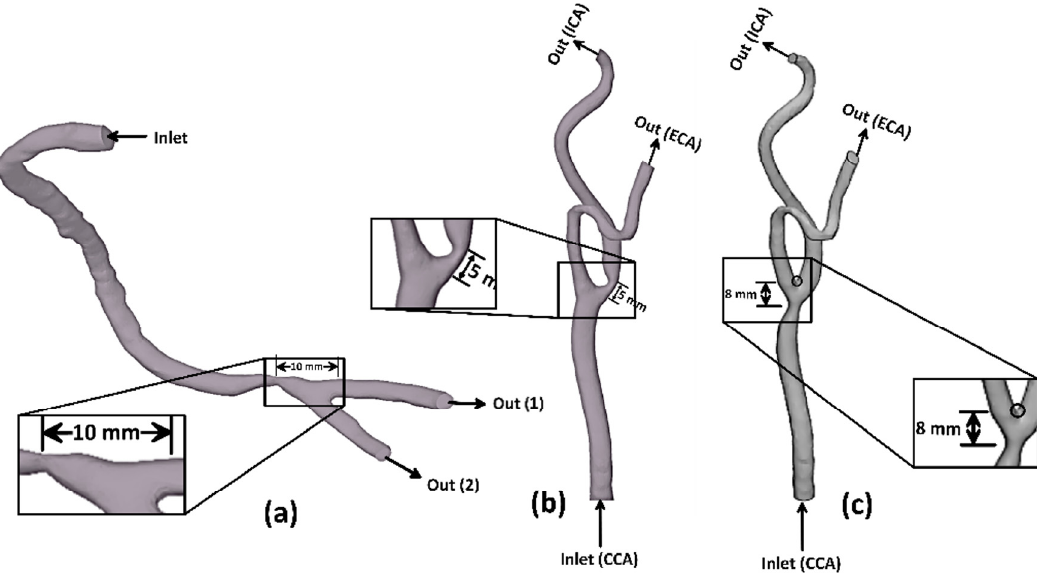
Figure 1. Physical model schematic diagram: ( a ) stenotic RCA—model A, ( b ) stenotic ICA—model B, and ( c ) stenotic CCA—model C. Table 1. Physical model dimensions.